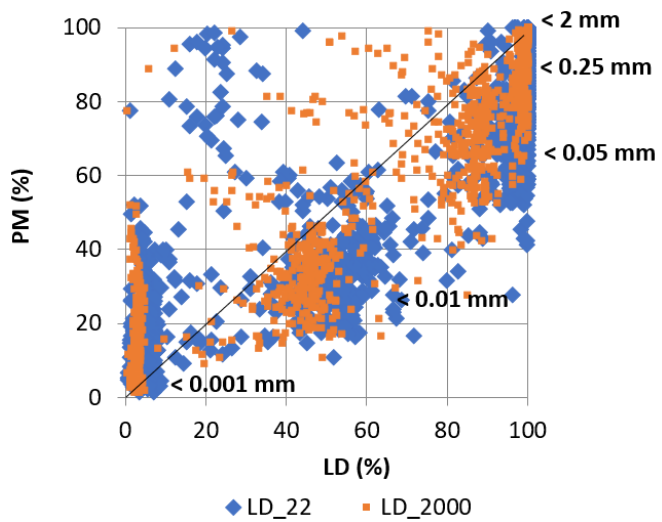
Figure 2. Comparison of cumulative particle size fractions representation determined by Analysette22 MicroTec plus (LD_22) and Mastersizer2000 (LD_2000) and pipette method (PM) for soil samples from three river basins. LD, laser diffraction.